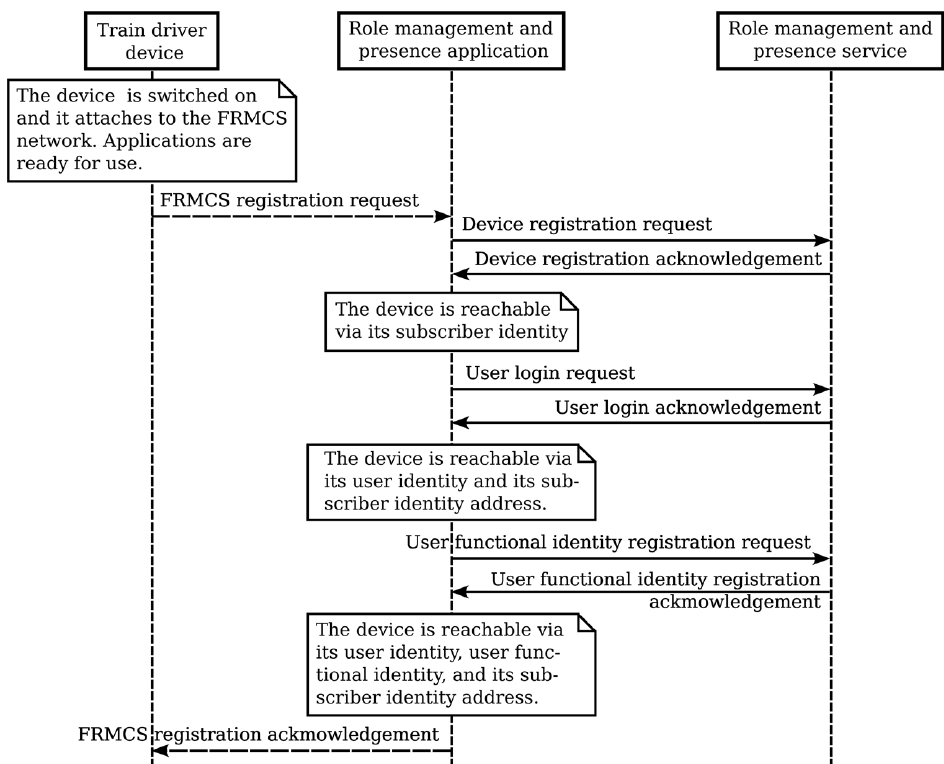
Figure 11. Services interaction flow for the initial registration of the device, user, and user’s func- tional identity.